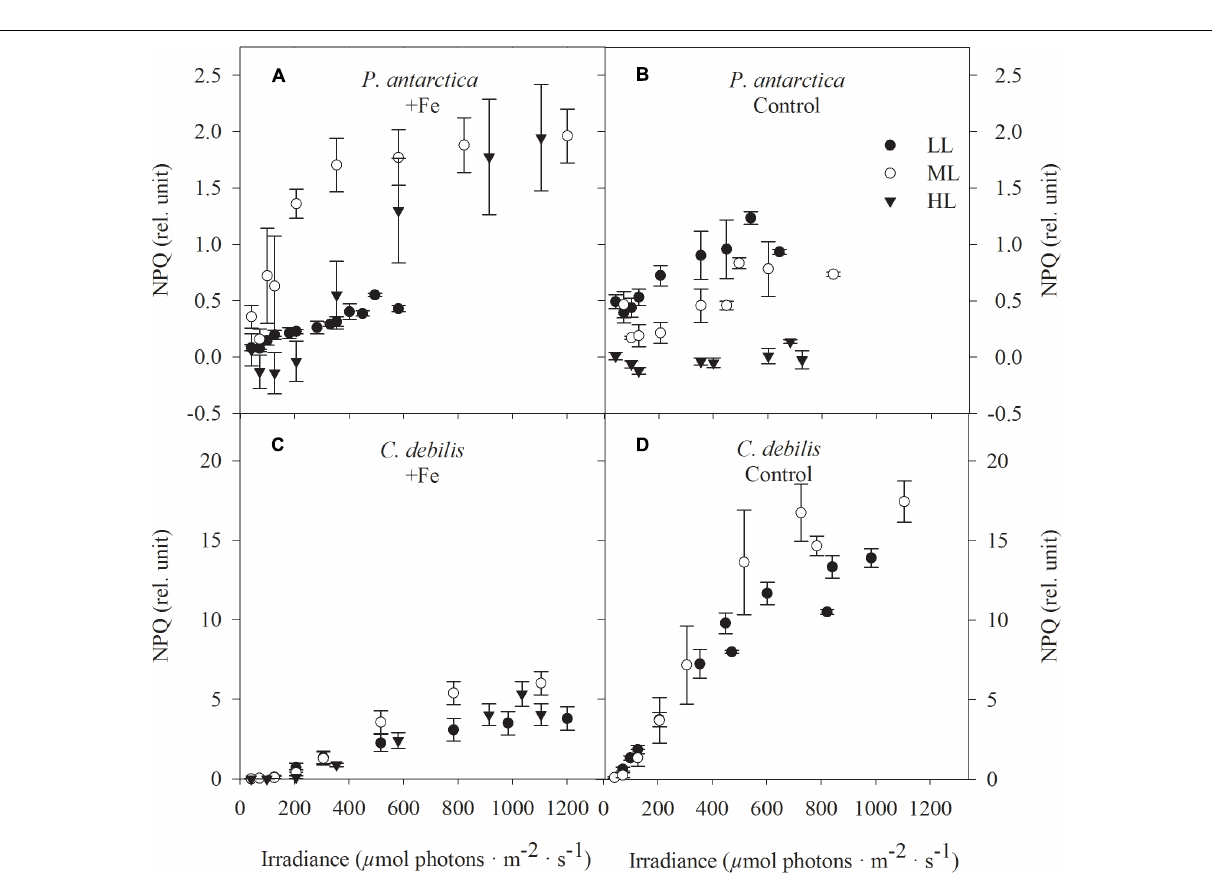
Frontiers in Marine Science | www.frontiersin.org